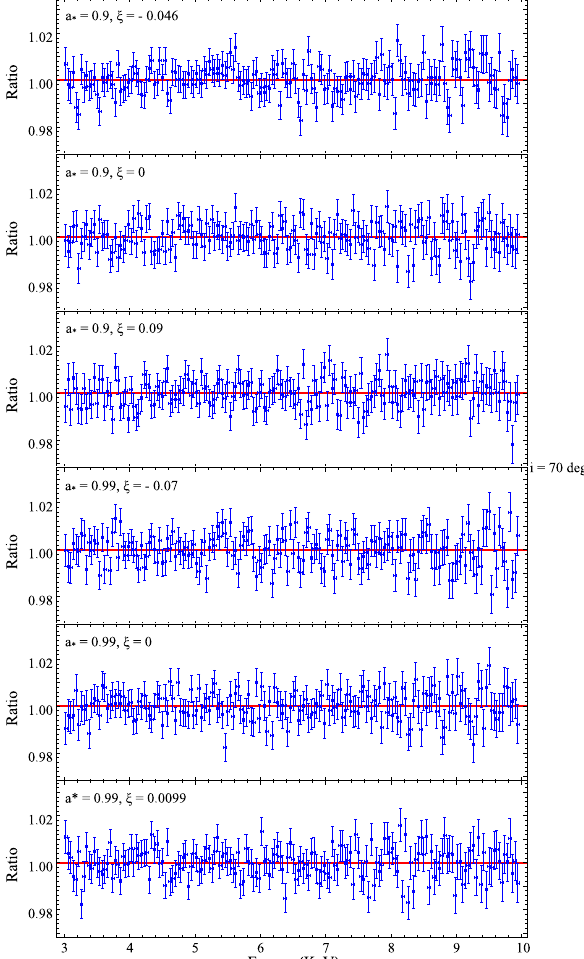
a single iron line) as well as configurations that should max- Fig. 5 Ratio data/best-fit model for simulations 6–11. See the text for more